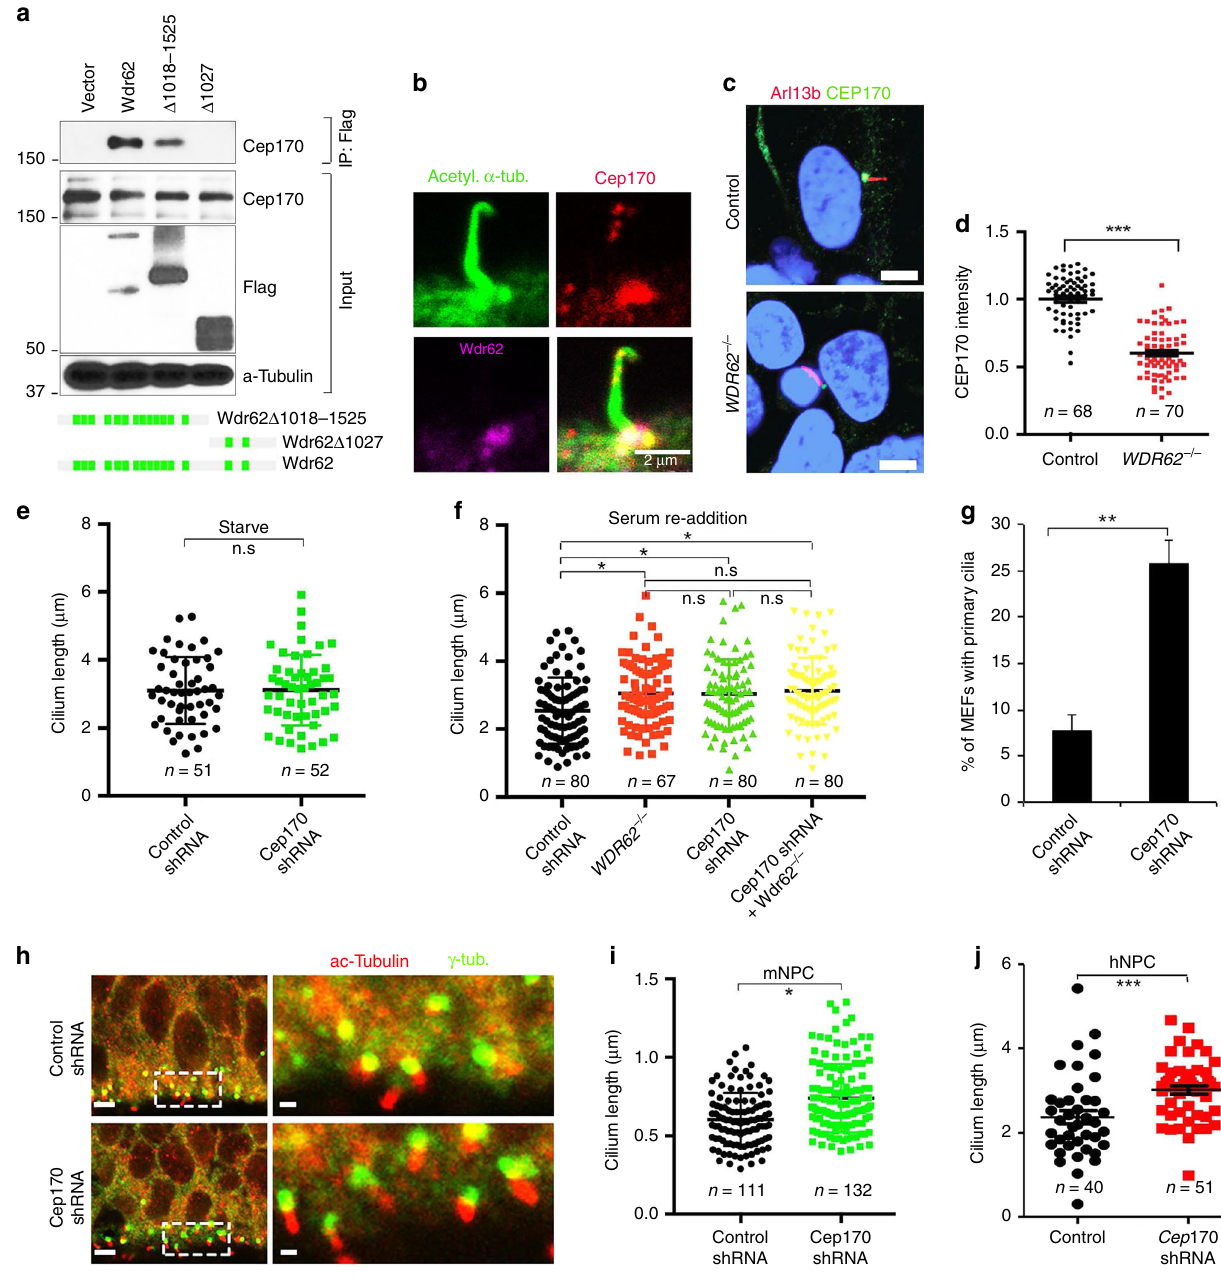
Fig. 7 WDR62 recruits CEP170 to the basal body for promoting cilium disassembly. a Cep170 interacts with Wdr62 by co-IP assay. Bottom panels: schematic diagrams of full length, N-terminal, and C-terminal Wdr62 constructs. b MEFs stained with antibodies against acetylated α -tubulin (green), Cep170 (red), and Wdr62 (purple). Scale bars: 2 μ m. c 2D human NPCs stained with antibodies against Arl13b (red) and CEP170 (green). Scale bars: 2.5 μ m. d Quanti fi cation of CEP170 signal intensity in control ( n = 68) and mutant ( n = 70) human NPCs with cilia. e Quanti fi cation of cilium length of control ( n = 51) and Cep170 knockdown ( n = 52) MEFs under serum starvation condition. f Quanti fi cation of cilium length of MEFs, including WT ( n = 80), Wdr62 − / − ( n = 67), Cep170 knockdown ( n = 80), and Cep170 knockdown in Wdr62 − / − ( n = 80) MEFs with cilia, after serum re-addition for 24 h. g Quanti fi cation of the percentage of ciliated MEFs out of total cells (~500 cells) at 24 h after serum re-addition. h Coronal sections of E16.5 cerebral cortex stained with antibodies against acetylated α -tubulin (red) and γ -tubulin (green). Control or Cep170 shRNA together with H2B-GFP constructs were injected into E14.5 ventricles. Right panels are enlargements of regions outlined by white dotted boxes in left panels. Scale bar: 5 μ m (left panels); 1 μ m (right panels). i Quanti fi cation of cilium length within a 1.153 × 10 5 μ m 2 fi eld in h . j Quanti fi cation of cilium length in WT ( n = 40) and CEP170 knockdown ( n = 51) human NPCs. Error bars represent SEM of three independent experiments. * P < 0.05; ** P < 0.01; *** P < 0.001; n.s. represents no signi fi cant difference detected (Student ’ s t